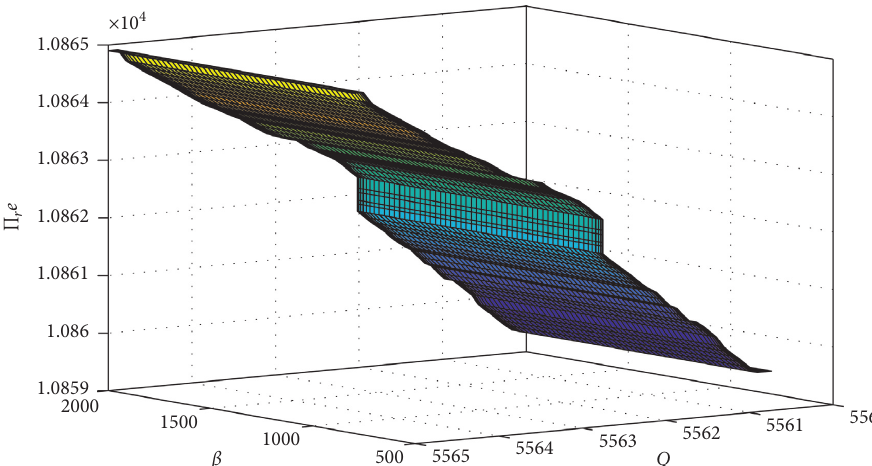
Figure 9: The impact of carbon emission reduction cost factors and order quantities on the revenue of recyclers under decentralized decision-making.